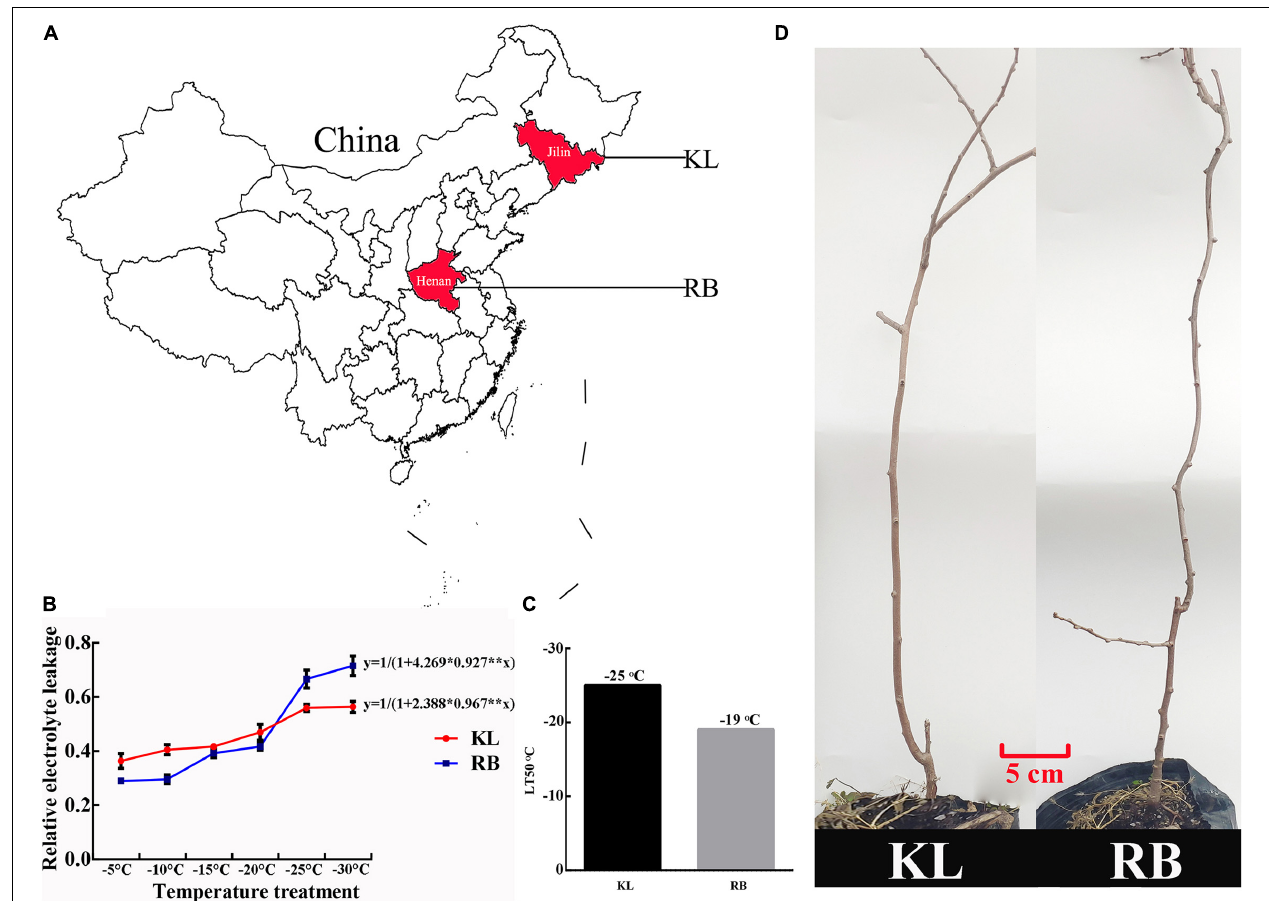
FIGURE 1 | Geographic distribution and freezing tolerance of the A. arguta KL and RB plants. (A) Both genotypes were derived from a different region; the KL came from Jilin province (125 ◦ E, 44 ◦ N), the RB was from Henan province (113 ◦ E, 34 ◦ N). (B) The logistic method was used to calculate the LT50 of each genotype. (C) KL and RB exhibited high ( − 25 ◦ C) and low ( − 19 ◦ C) freezing tolerance, respectively. (D) Three-year-old plants of both genotypes were used in this